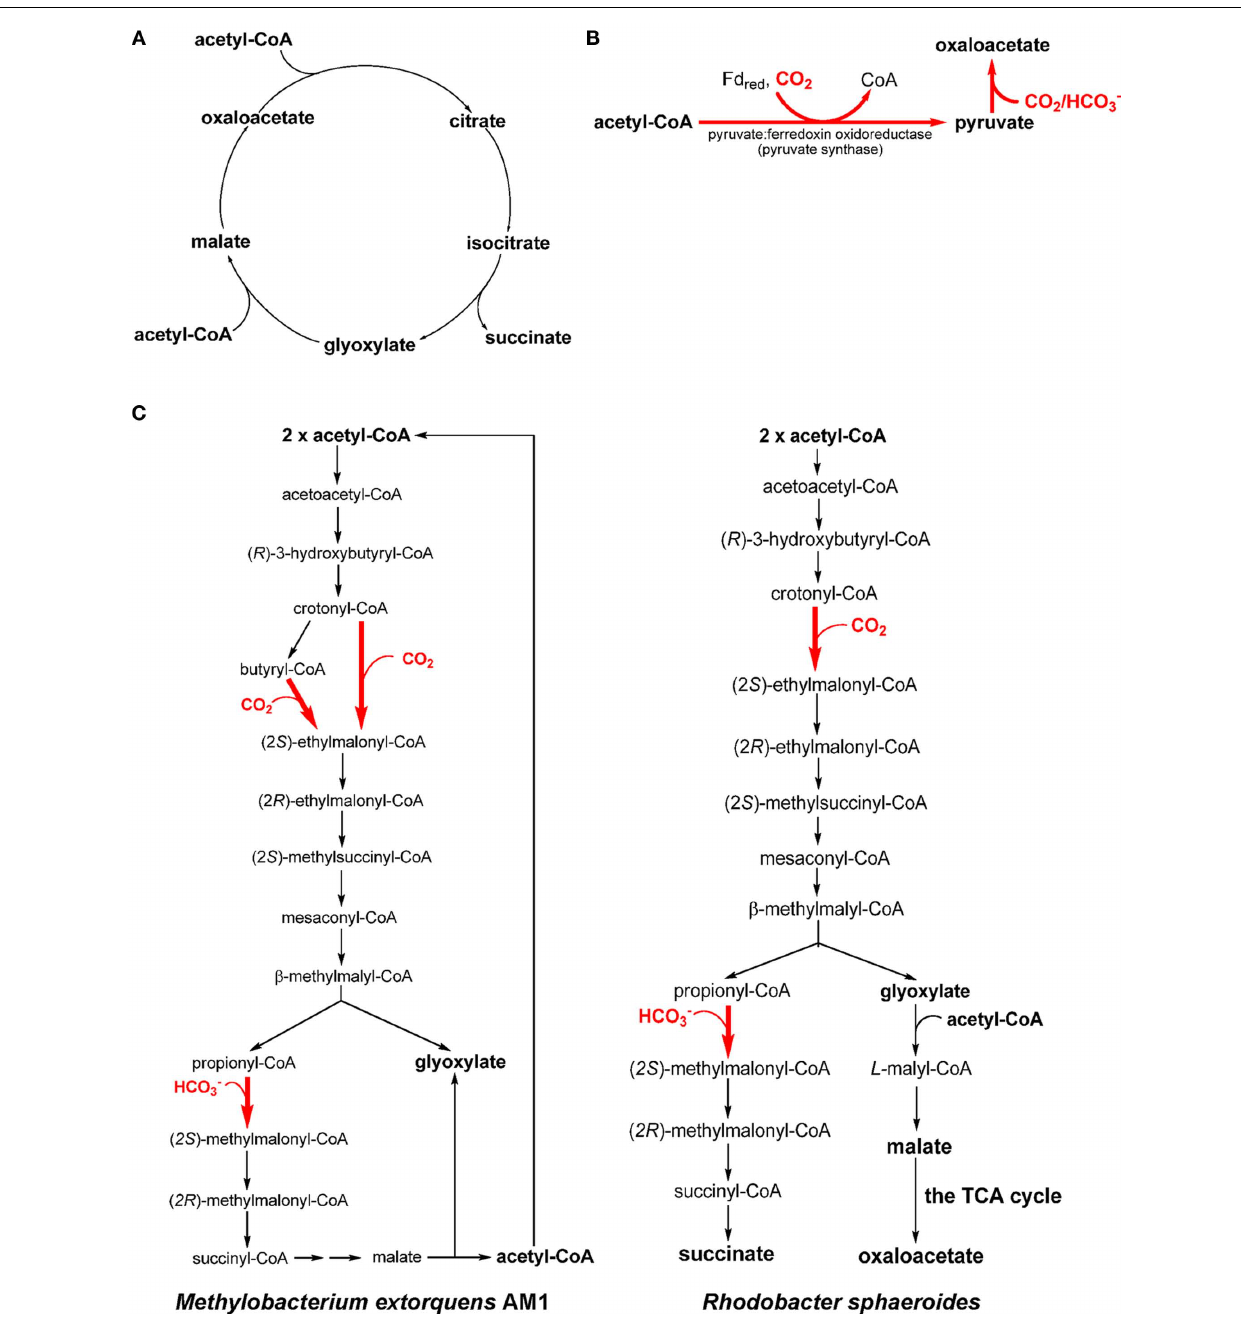
oxaloacetate.The CO 2 assimilation steps in the pathway/cycle are shown in bold and colored red. Different ethylmalonyl-CoA pathways have been reported in Methylobacterium extorquens AM1 [ (C) , left] and Rhodobacter sphaeroides [ (C) ,